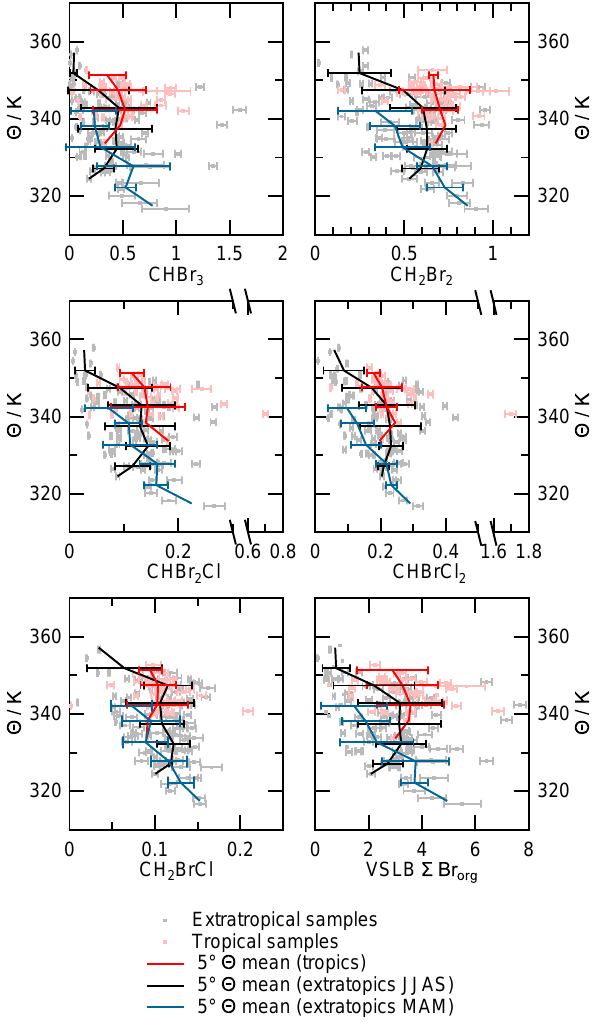
Fig. 4. Plots of VSLB and total VSLB-derived bromine (VSLB 6 Br org ) for Central American flights against potential temperature ( 2 ) with 5K means. 5K means with 1 σ error bars representing variability are separated into extra-tropical from March, April and May (MAM); extra-tropical from June, July, August and Septem- ber (JJAS) and tropical samples from all months. Where fewer than three data points were available for averaging, error bars have not been added. Error bars on sample data points represent analytical uncertainties. All VSLB values on the horizontal axes are given in ppt.